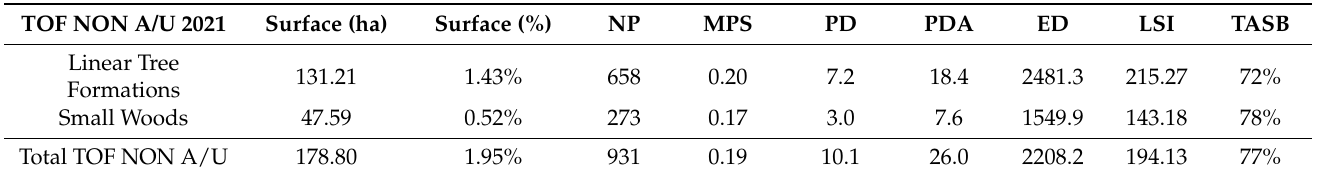
Table 2. Landscape ecology indexes calculated for TOF NON A/U for 2021. The third column refers to the percentage calculated respective to the total surface of the Core